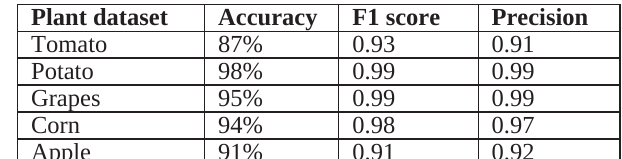
Table 2. Performance Measure Classification